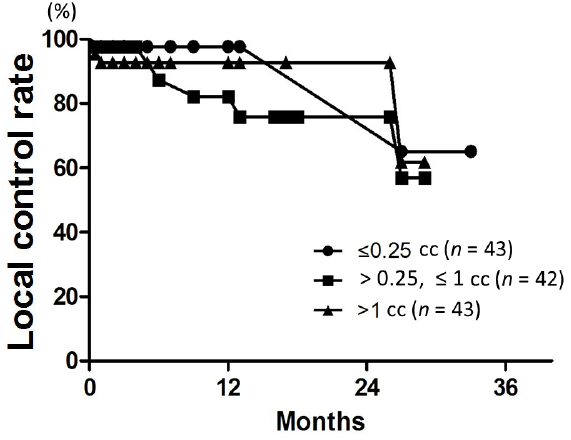
Table 4. Multivariate analysis for prognostic factors affecting LC, OS, and FDBF. Factor (sort, n ) Tumor number (1 vs. ≥ 2, 22 vs. 32) Cumulative GTV (<2 vs. ≥ 2 cc, 100 vs. 28) (controlled vs. uncontrolled, 11 vs.